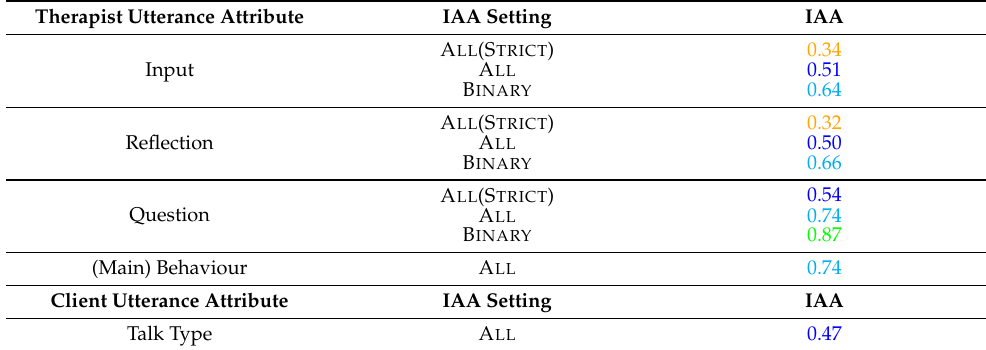
Table 9. Inter-annotator agreements on utterance-level annotations, in Fleiss’ kappa. Orange, blue, cyan, and green indicate fair (0.21–0.40), moderate (0.41–0.60), substantial (0.61–0.80), and almost perfect (0.80–1.00) agreement,